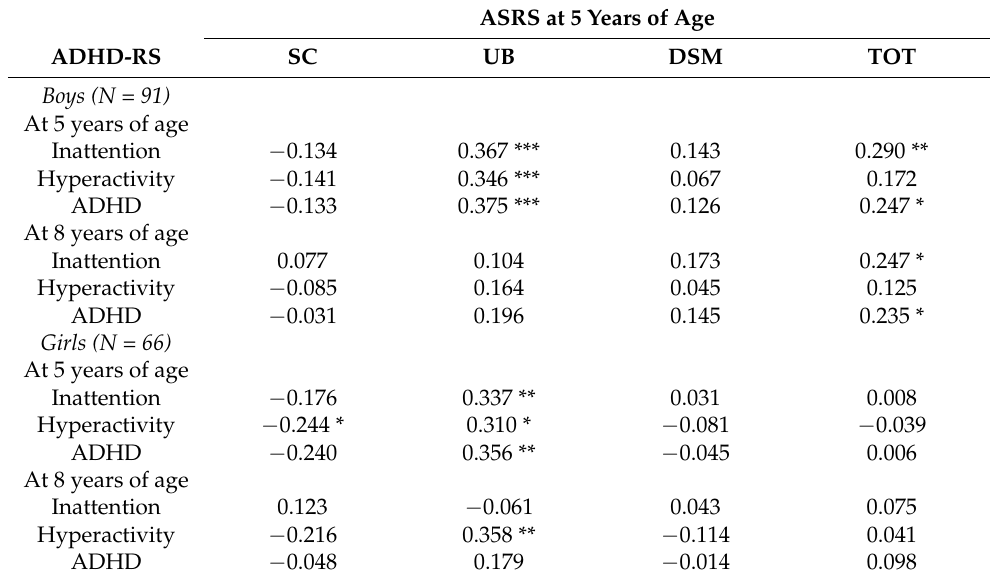
Table 6. Correlations between ADHD rating scores at 5 and 8 years of age and ASRS scores at 5 years of age (Spearman’s